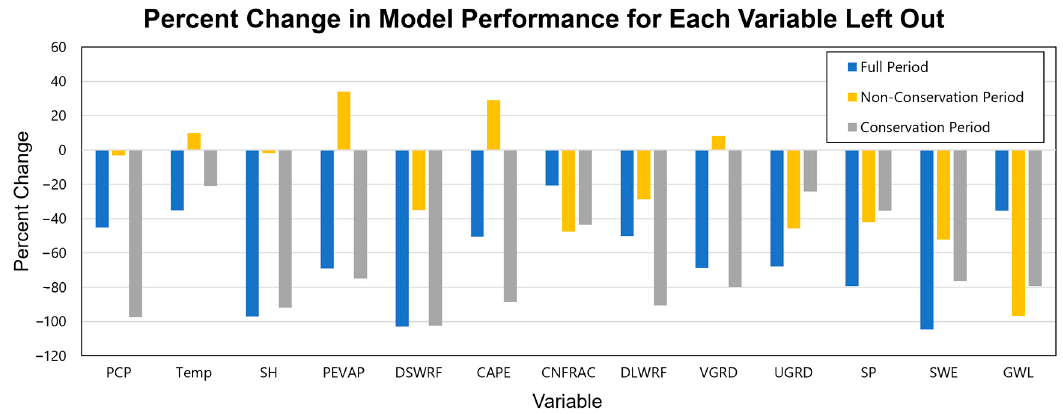
Figure 5. Percent change in model performance by time period due to each variable left out.